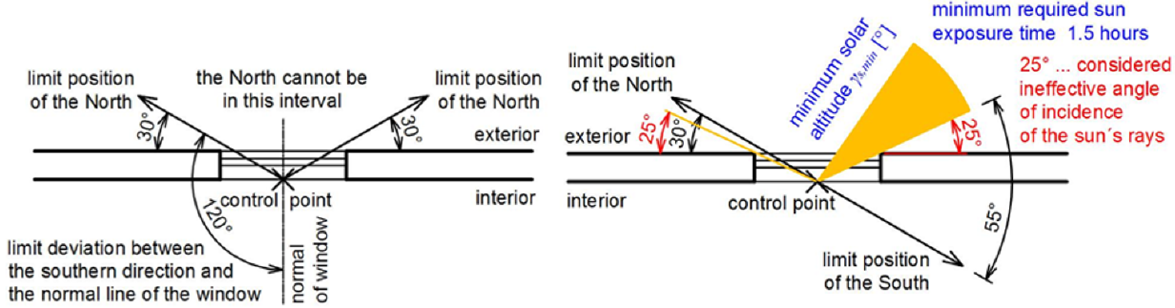
Figure 3. Recommended window orientation to cardinal points (on the left) and marginal condition of calculating the minimum solar altitude (on the